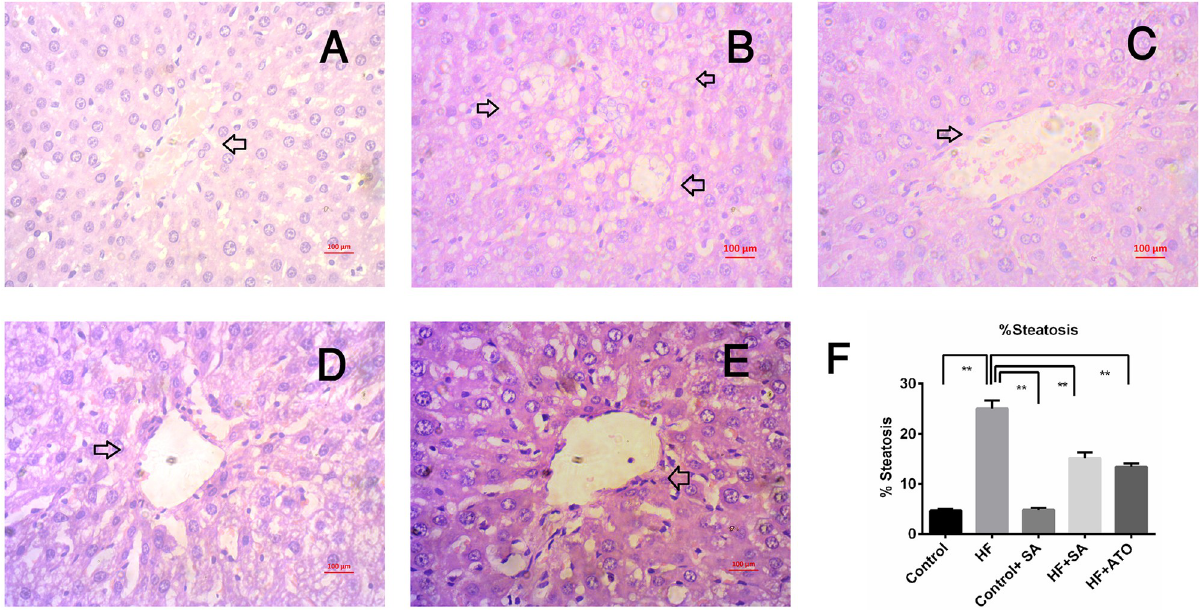
Fig 10. Effect of Senna alexandrina leaf powder supplementation on lipid accumulation in liver of high-fat diet-fed rats. A for control; B for HF; C for Control+SA; D for HF+SA; E for HF+ATO group and F for % Steatosis. Magnifications 40X.